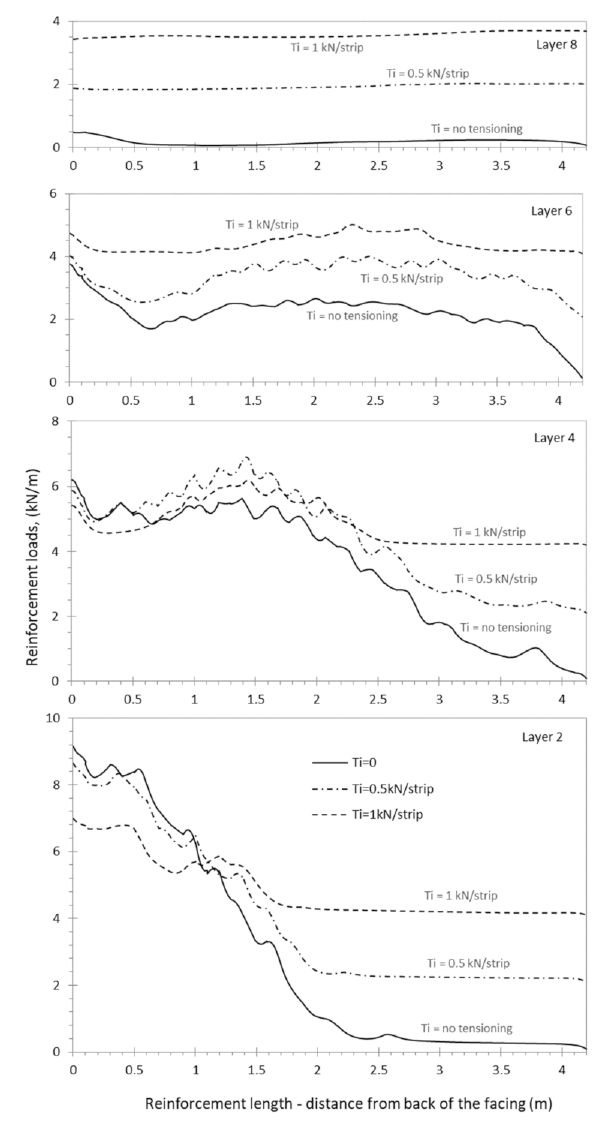
Figure 21. Reinforcement loads for D i = 0.6 H case at the end of construction (EoC) and different pre-tensioning loads. (Modified from